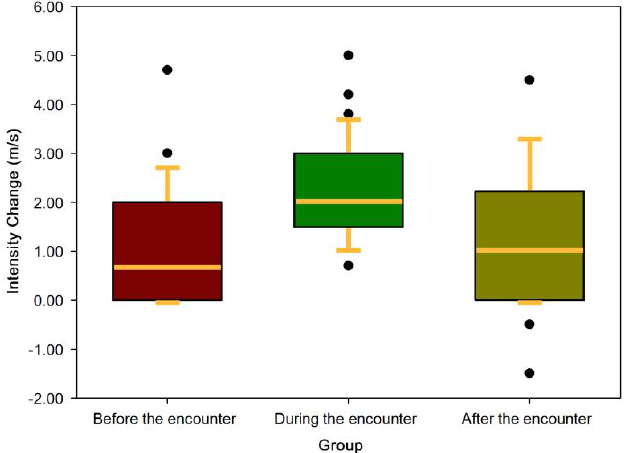
Figure 8. Cell-based average of the variations in maximum wind speed along TCs from 1949 to 2013. The blue dots show warm ocean eddies that encountered intensifying TCs in the South China Sea.